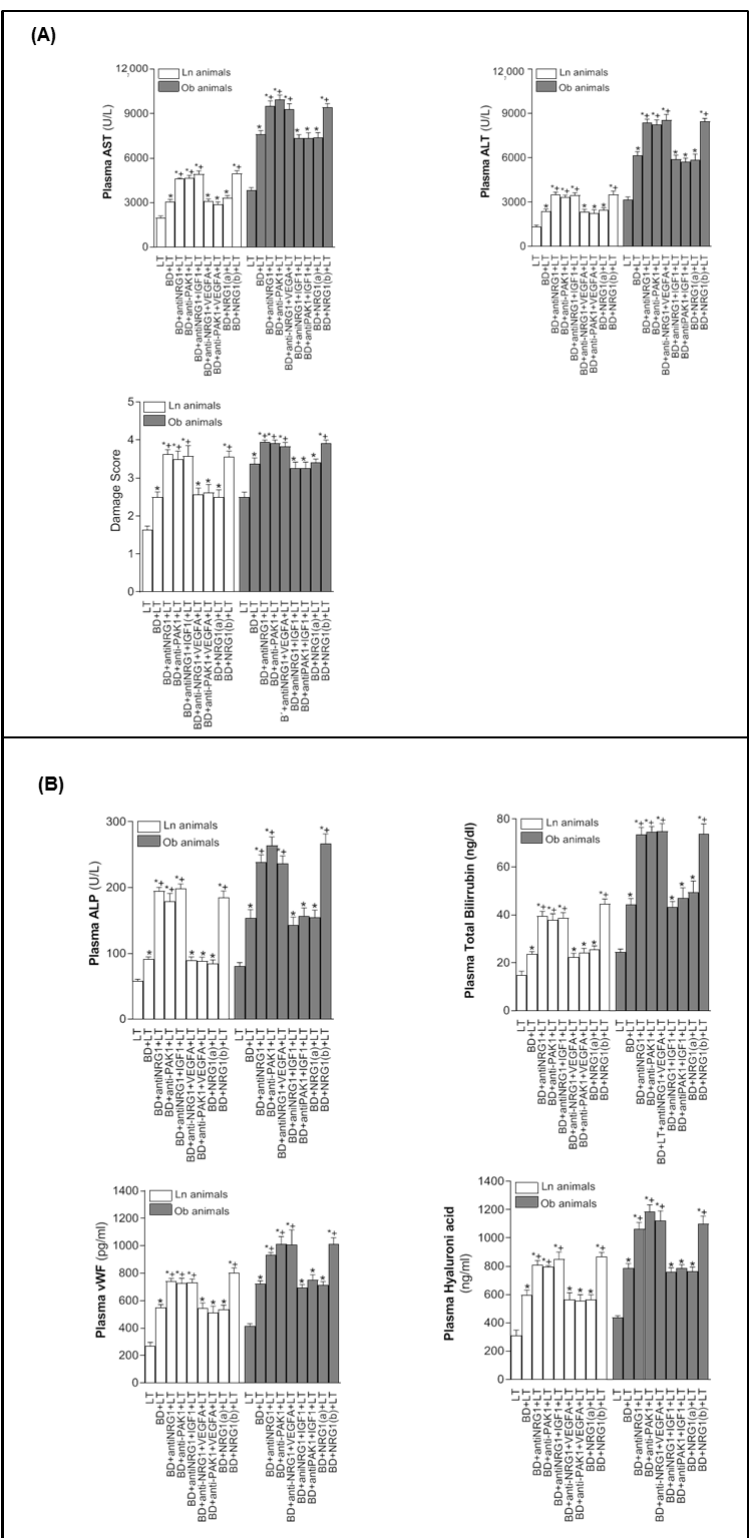
Figure 2. The relevance of NRG1 on injury in steatotic and non-steatotic LT from DBDs in a genetic obesity model. ( A ). ALT and AST levels in plasma, and damage score in the liver. ( B ) ALP, total bilirubin levels, vWF, and HA levels in plasma. * p < 0.05 vs. LT; + p < 0.05 vs. BD+LT.